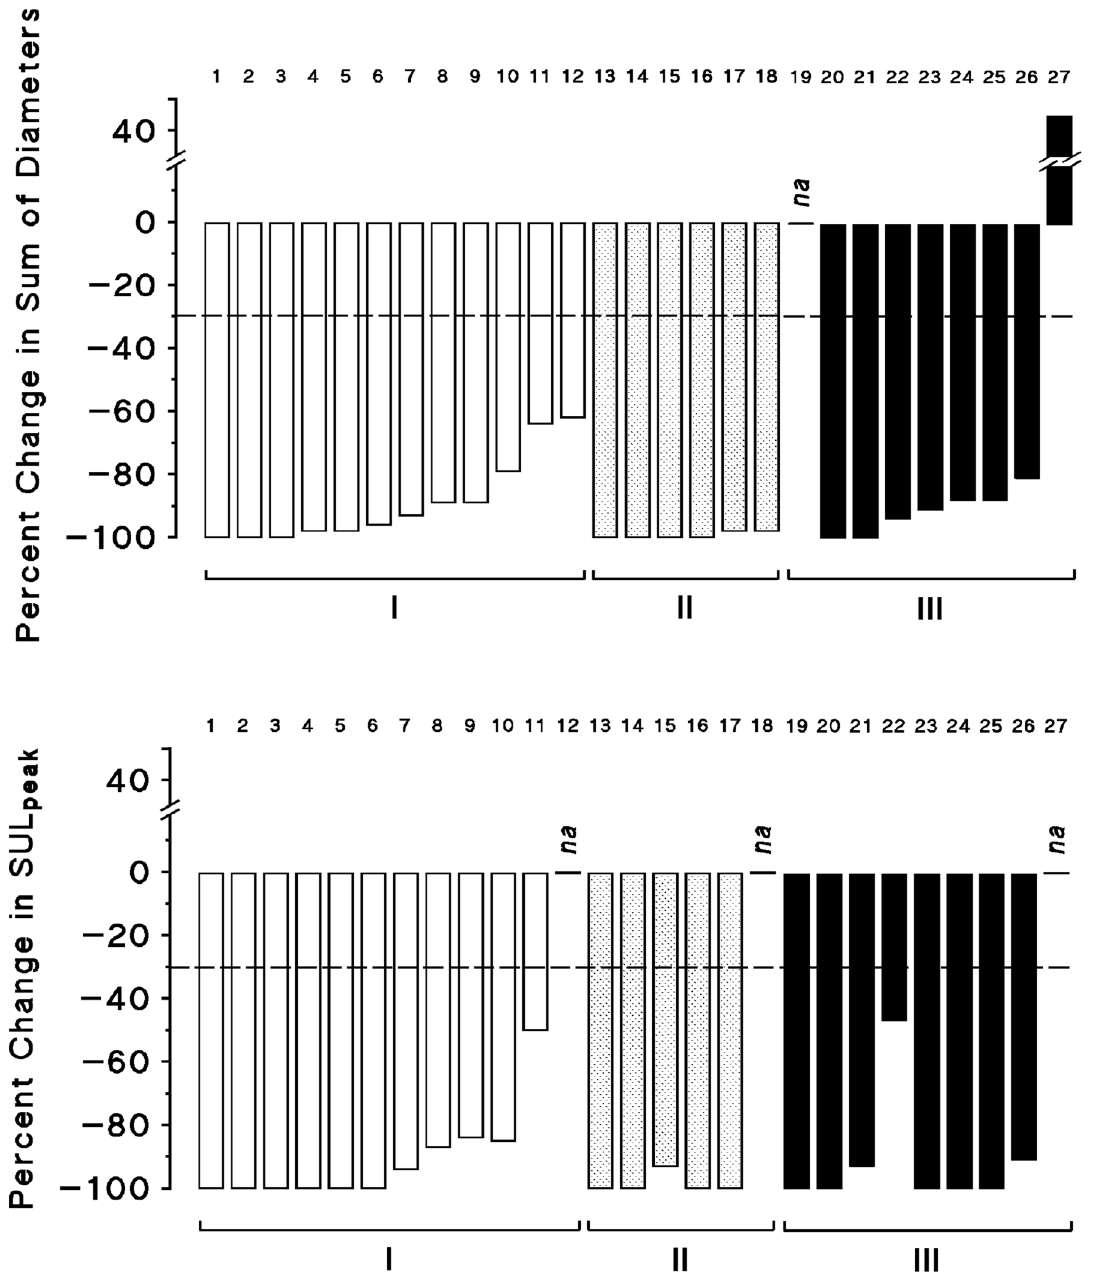
Figure 3. Magnitude of clinical and metabolic response in advanced breast carcinoma patients treated with regimens comprising FUra, FA, and pyridoxine in tandem. Patients in abscissa comprise I, previously untreated patients whose tumors did not overexpress HER2 (1–12); II, previously untreated patients whose tumors overexpressed (3+) HER2 (13–18); and III, previously treated patients whose tumors did not overexpress HER2 (19–27). In patients who had great numbers of targets who attained a partial response accompanied by disappearance of most metastases, calculations of percent reduction in sum of diameters (RECIST; Response Evaluation Criteria in Solid Tumors) were done by size comparison of remaining images at the time of assessment with these same tumor images present before treatment. Metabolic response was assessed by the percent variation in peak standard 18 FDG uptake value normalized by lean body mass (SUL peak ) obtained by PET scan (PERCIST; Positron Emission Tomography (PET) Response Evaluation Criteria in Solid Tumors). Three responders were not assessed by both methods ( na in bar plots). The discontinuous line at − 30%, represents the limit between no change and antitumor